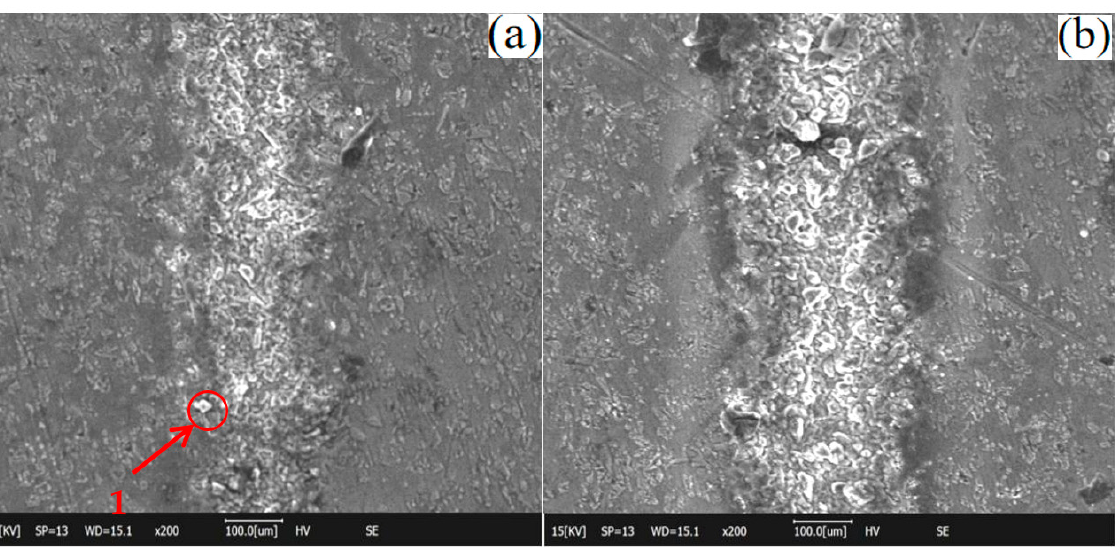
Figure 6. ( a ) Heat-affected zone trend graph; ( b ) comparison of etching width and depth variation. After scanning electron microscopy (SEM) observation of the processed material, the SEM image of the composite material was obtained, as shown in Figure 7 below.